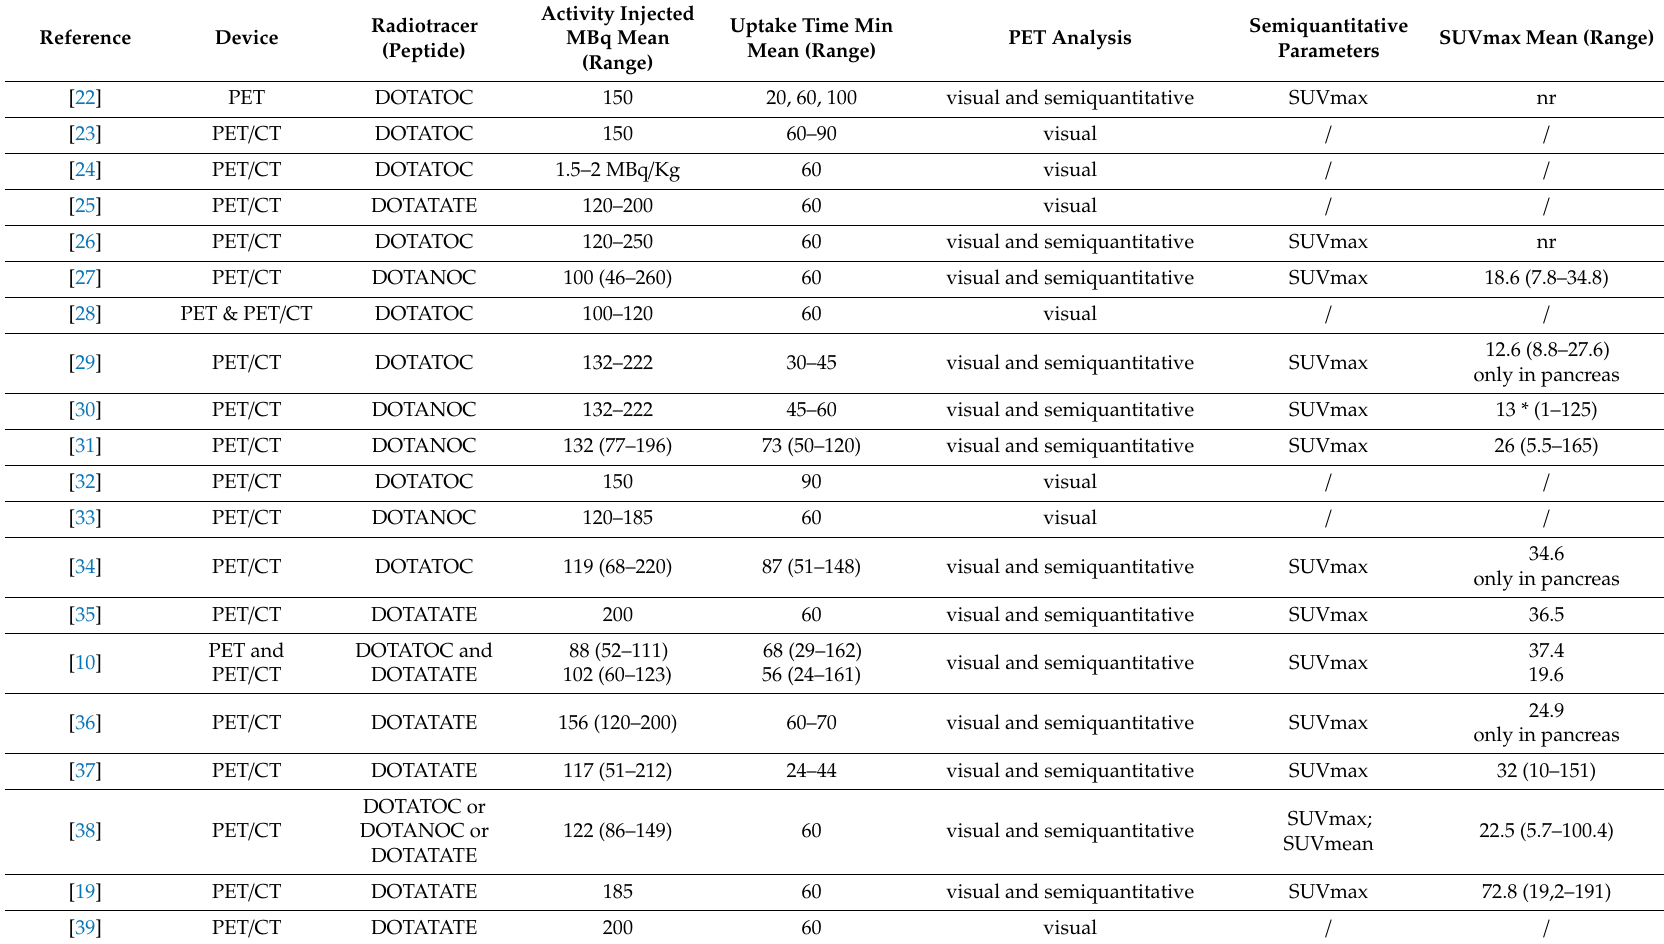
Table 2. Technical features of included